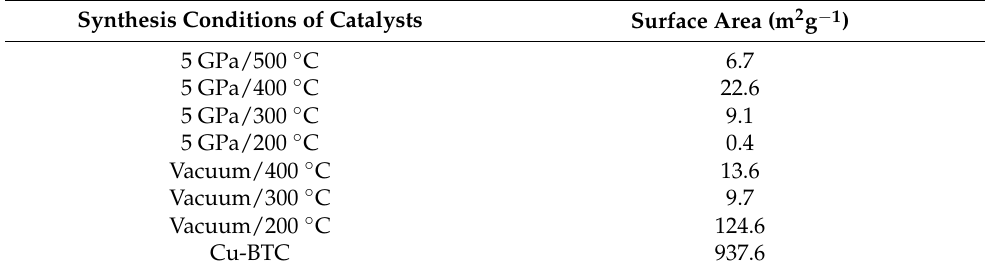
Table 3. Surface areas measured by N 2 adsorption and the BET method of MOF-derived Cu@C materials, pristine Cu-BTC.